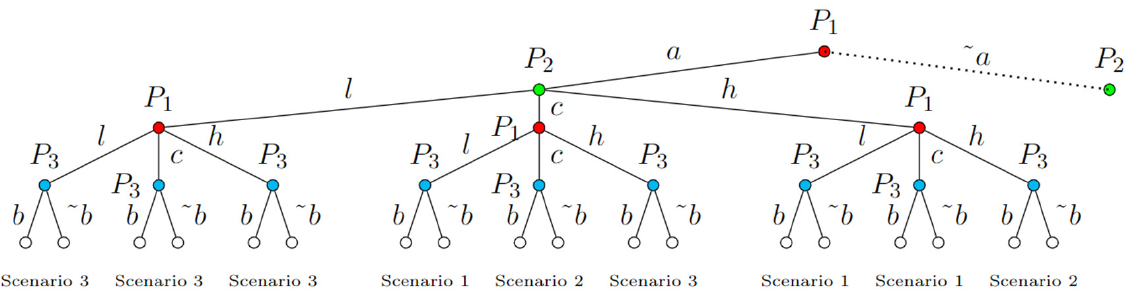
Figure 3. Full game tree, P 1 : United States, P 2 : Russia, P 3 : Japan, a : sanction, l : set price lower than the market average, c : competitive prices relative to the market, h : set prices higher than the market average, b : diversify. The dotted line represents a duplicate tree not drawn due to space limitations. ˜ indicates reverse moves (˜ a : not sanction).